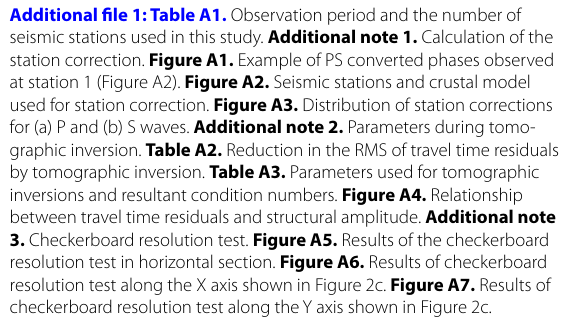
Abbreviations OBS: ocean-bottom seismometer; PAC: Pacific plate; NA: North American plate; PHS: Philippine Sea plate; ERI: Earthquake Research Institute; JAMSTEC: Japan Agency of Marine-Earth Science and Technology; NIED: National Research Institute for Earth Science and Disaster Prevention; JMA: Japan Meteorological Agency; DWS: derivative weight sum.